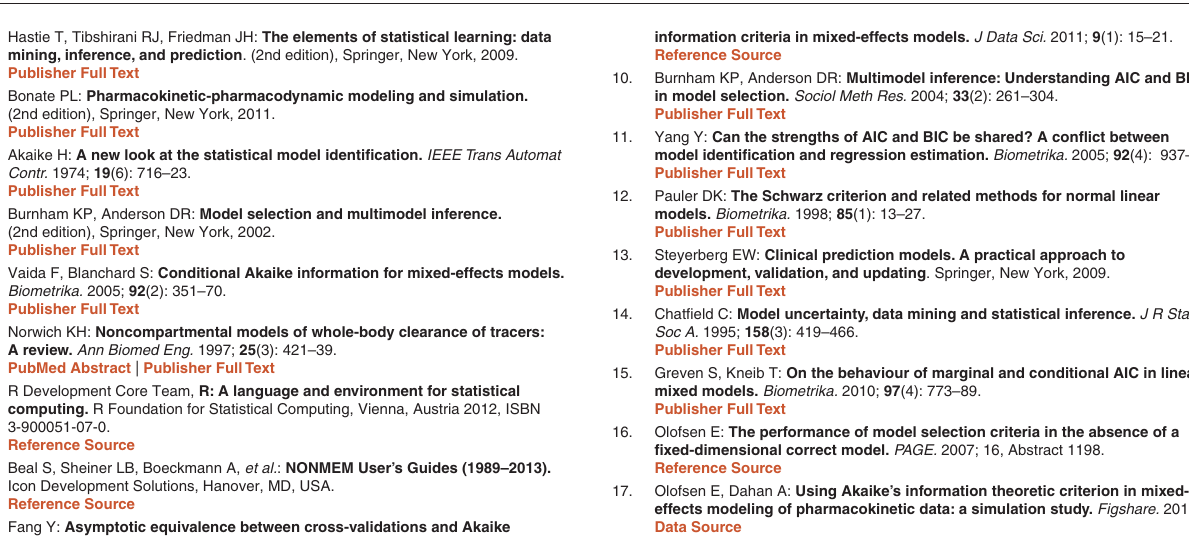
Figure 6 depicts the normalized log-likelihood (with equation (23) evaluated numerically) as a function of ω 2 , for σ 2 = 0.5 and three values of M . For large M , the last term in equation (23) (the integral divided by M ) goes to zero, and the uncertainty left in the data is determined only by σ 2 . Values for M = 11, and ω 2 = 0, 0.1, and 0.5 were used as “target” values in Figure 3–Figure 5. The observed averaged normalized log-likelihoods will be larger, because the models used do not fit perfectly, and the parameters are estimated instead of set to their true values. The context of AIC is also the one where the η s have been inte- grated out (but with the parameters at their estimated values), which of the set of (validation) data are optimally captured, this context is different from the case where prediction errors are calculated with the random effects set to zero instead of integrated out. In that case, the above AIC and OFV criteria do not match, as the components v can only independent if the true values of η for the individuals are also zero). Note however, that from the higher perspective of opti- important